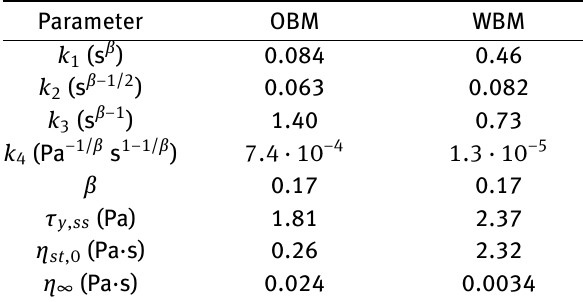
Table 2: Dullaert-Mewis model parameter estimates. Parameter OBM WBM